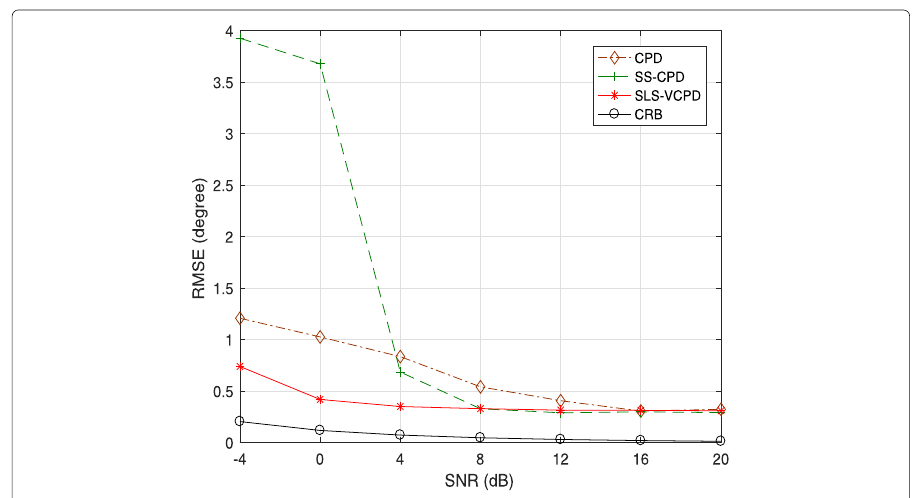
Fig. 11 RMSE versus SNR for ten sources with M = 6 and T = 2000